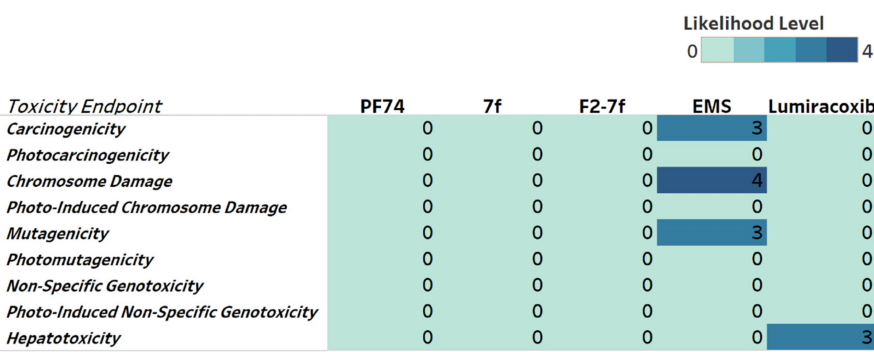
Figure 8. Genotoxicity and hepatotoxicity endpoints for selected compounds. The highlighted table shows the StarDrop V7 (Optibrium, Ltd., Cambridge, UK)–derived toxicity endpoints using the Derek Nexus module with knowledge-based prediction. Structural alerts within the molecule with a level of likelihood for concern are based on precedence from experimental data. Likelihood level 0 = No report; 1 = Inactive; 2 = Equivocal; 3 = Plausible; 4 = Probable. Ethyl methanesulfonate (EMS) was used as a positive control for genotoxicity, and lumiracoxib was a positive control for hepatotoxicity endpoints.